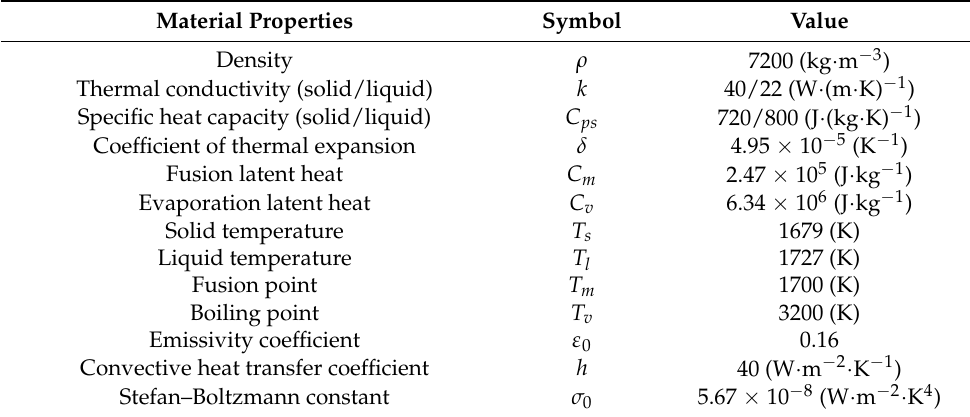
Table 3. Physical properties of 304 stainless